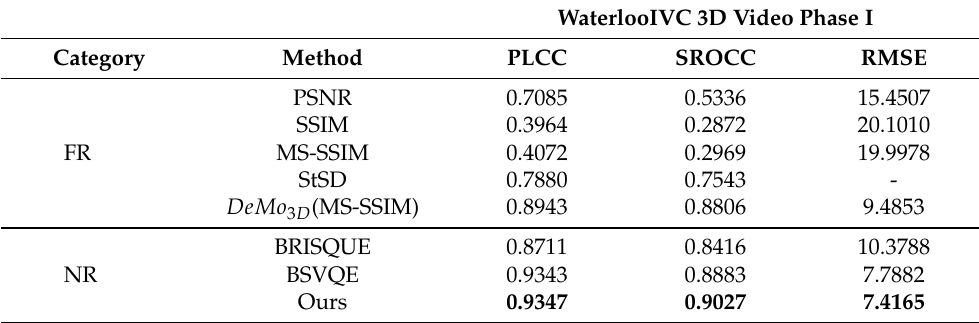
Table 5. Eight methods for overall and individual distortion performance on WaterlooIVC 3D Video Phase I. The best results are in